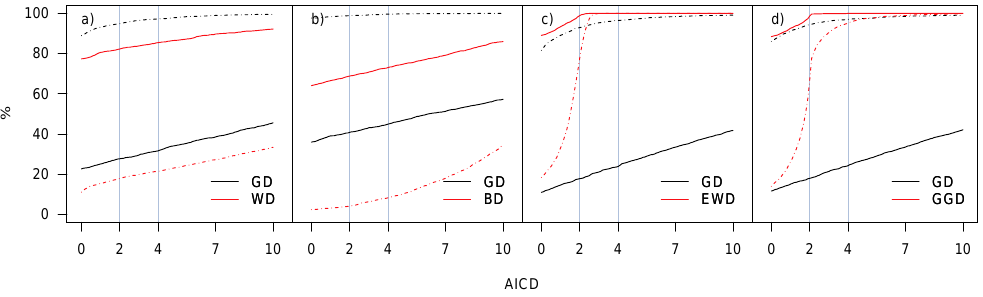
Fig. 9. AICD frequencies (ECHAM5 data set): percentages of all grid points and months a distribution yields AICD smaller or equal than a given value for the European region. The GD (black lines) is compared to a) WD, b) BD, c) EWD and d) GGD (red lines). Dashed-dotted lines with corresponding colors show the respective outcome for a simulated data set, representing Gamma distributed precipitation in Europe.